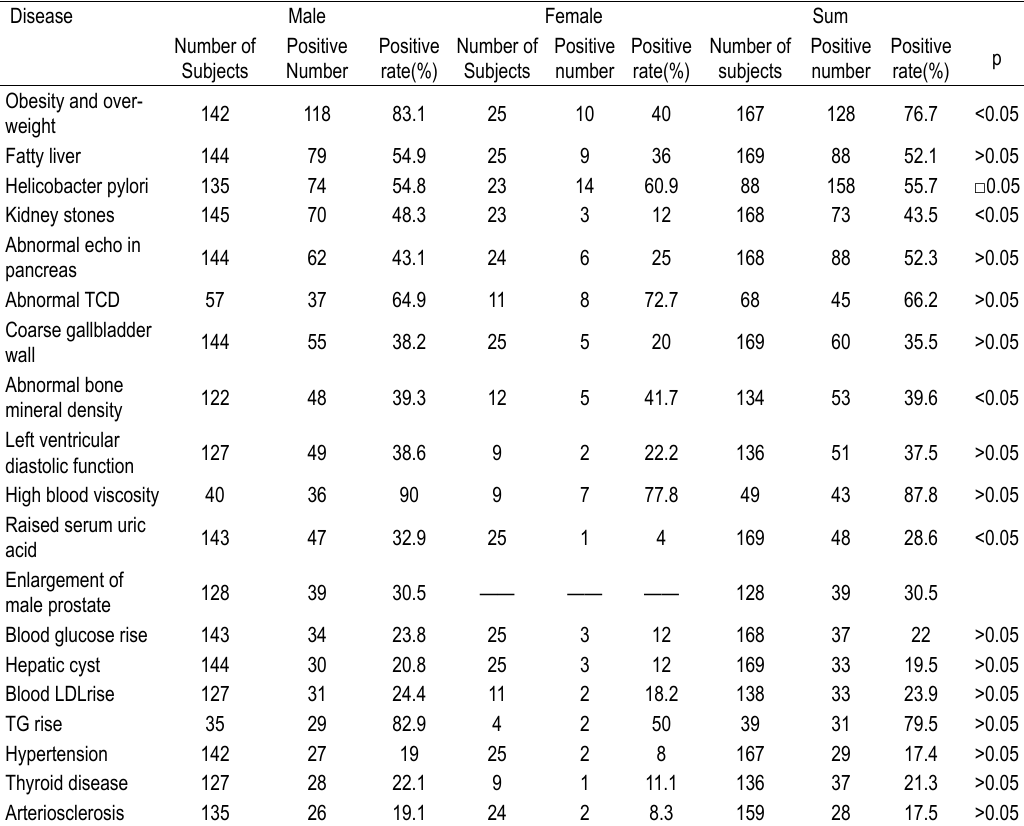
Table 2. Disease Spectrum of Corporate